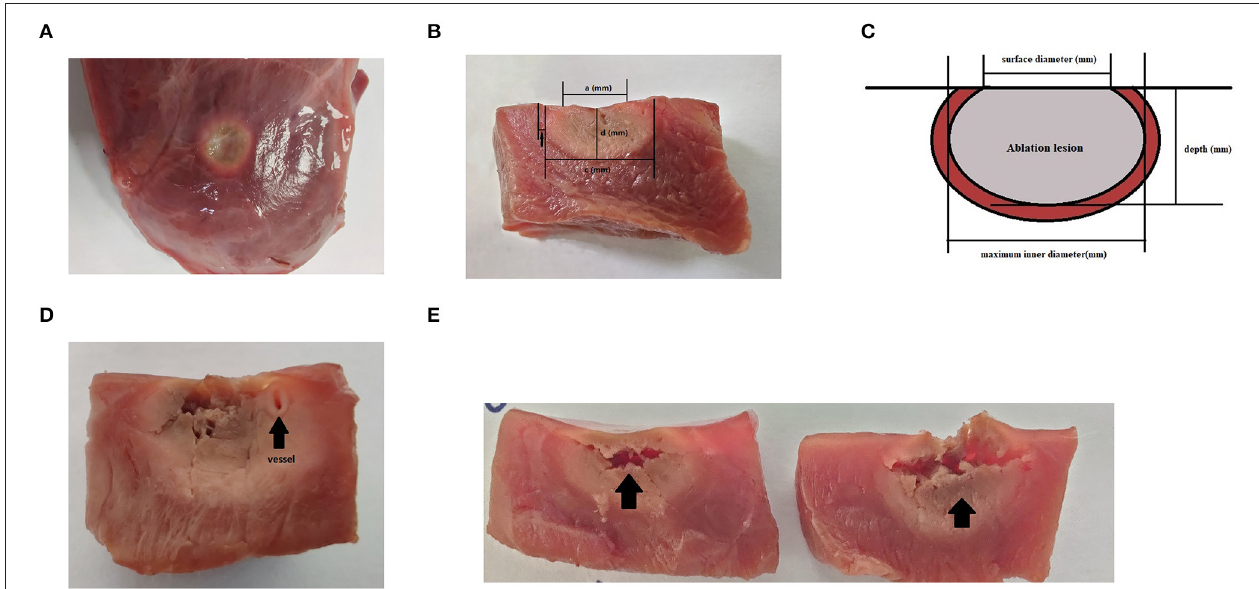
FIGURE 2 | Lesions after 20min of waiting after radiofrequency catheter ablation (RFCA). (A) The surface view of the ablation lesion, which is a perfect circle. The pale part is the ablation lesion, while the area indicated by black arrows is the hyperemia and edema area. (B) The transverse section of an oval ablation lesion. The lesion border was defined as the tissue color. (C) A schematic diagram of the measurement diameter of the ablation lesion, where “a” represents the surface diameter, “c” represents the maximum diameter, and “d” stands for depth. Each diameter line was measured using an electronic vernier caliper. (D) A steam pop with a small blood vessel visible at the arrowhead. (E) A steam pop with a horizontal tear in the